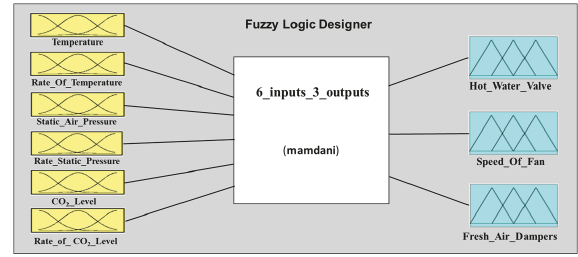
Figure 9: Fuzzy logic designer app.